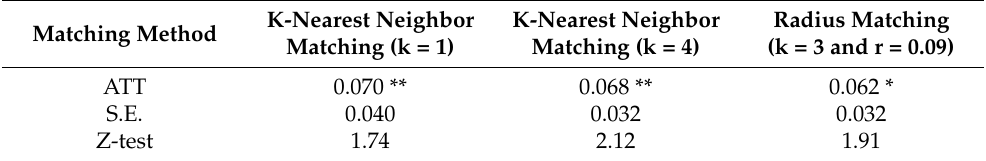
Table 4. Estimation Results Based on the PSM